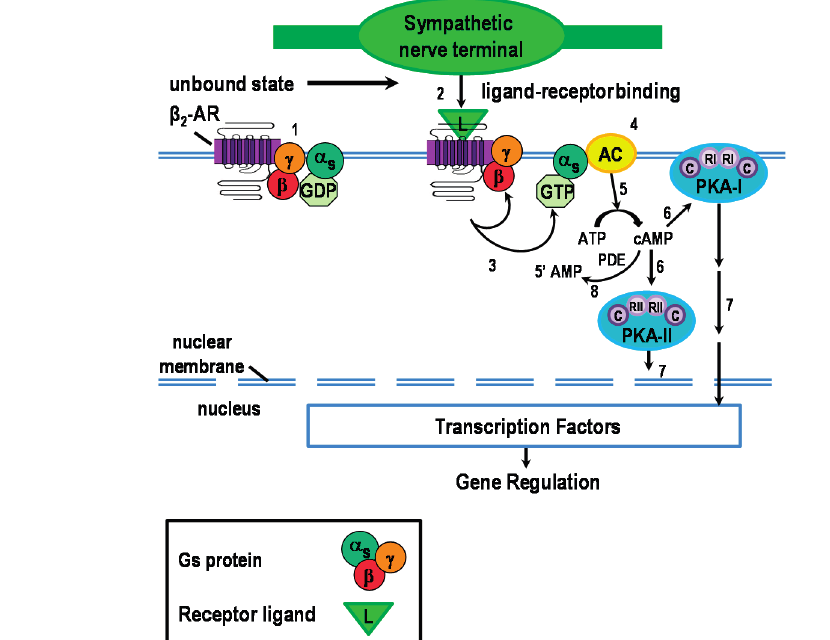
Figure 1. The canonical β 2 -adrenergic receptor (AR) signaling pathway is illustrated here. In target tissues, activated sympathetic nerves release the neurotransmitter, norepinephrine (NE) from “boutons en passage”. NE and epinephrine from the circulation are the natural ligands (L) for the β 2 -AR. β 2 -ARs couple with stimulatory G α s subunit to modulate the activity of adenylate cyclase (AC). Receptor activation causes dissociation of G α s from the G βγ subunit complex of the Gs protein, which results in AC-mediated production of cAMP from ATP. Next, cAMP activates either protein kinase A-I (PKA-I) or -II. PKA activation leads to the activation of transcription factors such as cAMP response element-binding (CREB) protein to regulate gene